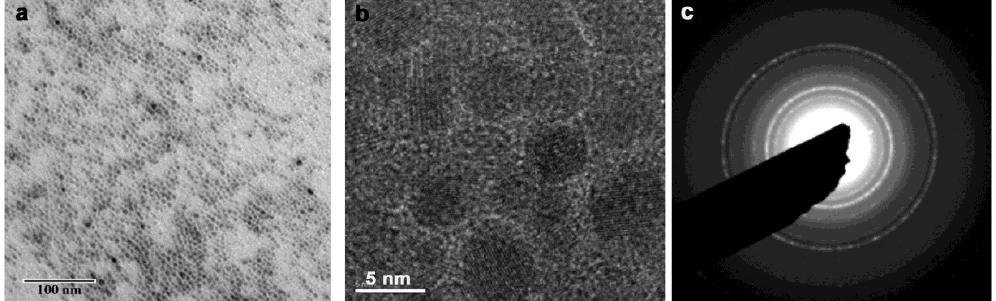
Figure 1. ( a ) Transmission electron micrograph; ( b ) High-resolution transmission electron micrograph; ( c ) Selected area electron diffraction pattern of Fe 3 O 4 nanoparticles.